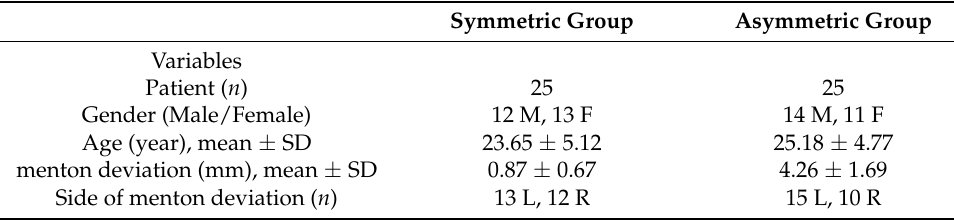
Table 2. Demographic characteristics of included subjects.